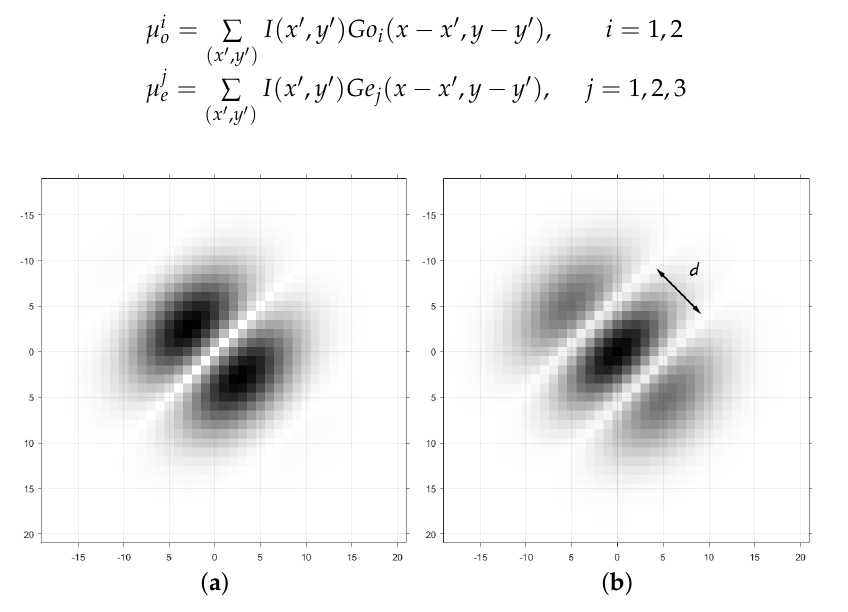
Figure 4. Gabor filters at orientation pi /4. ( a ) The odd-symmetric filter; ( b ) The even-symmetric